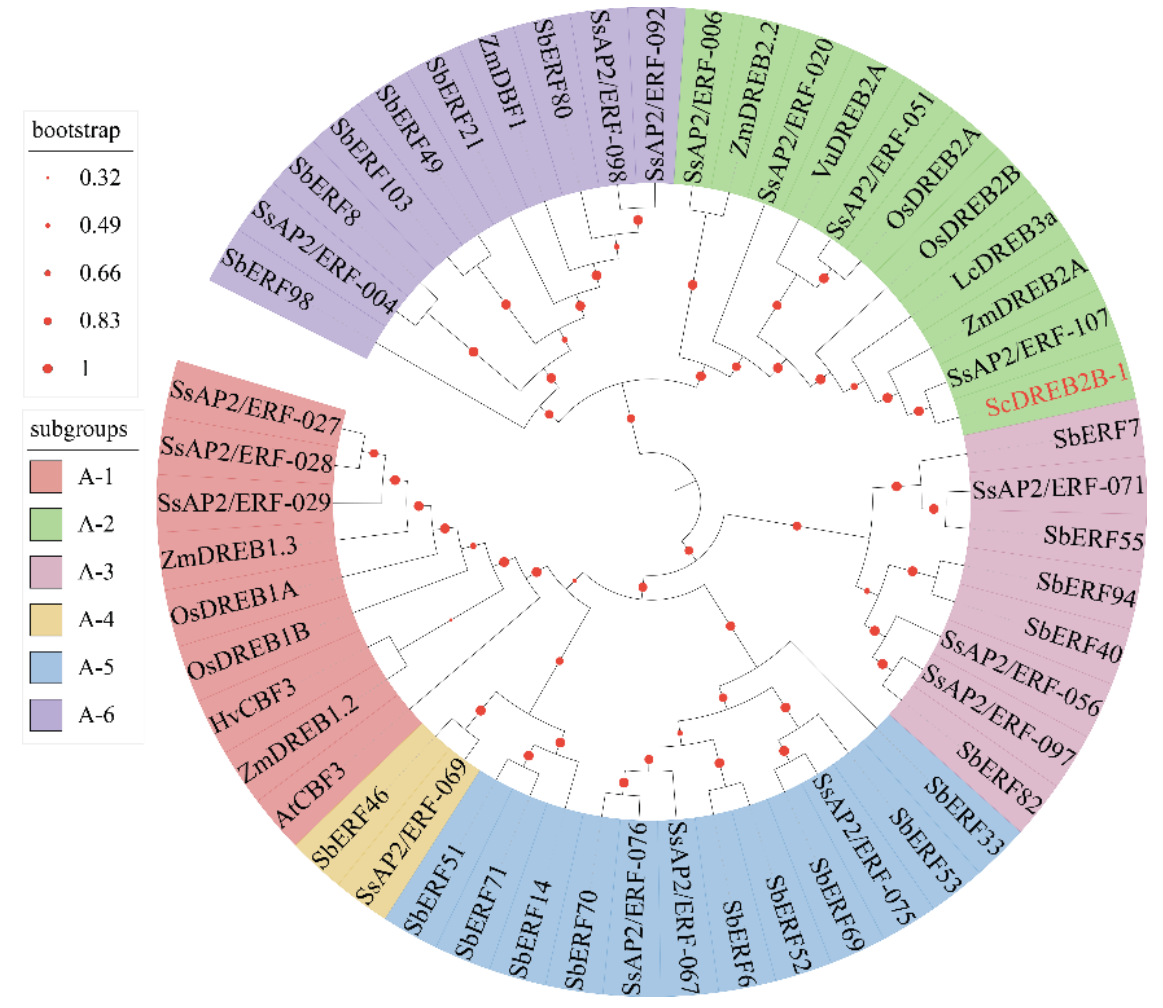
Figure 2. Phylogenetic tree analysis of ScDREB2B-1 protein in sugarcane and typical DREB (A-1-A-6) proteins in other plant species. The red font was the ScDREB2B-1 protein. Os, Zm, Sb, Ss, Lc, Vu, At and Hv represented Oryza sativa , Zea mays , Sorghum bicolor , Saccharum spontaneum , Leymus chinensis , Vigna unguiculata , Arabidopsis thaliana and Hordeum vulgare , respectively.